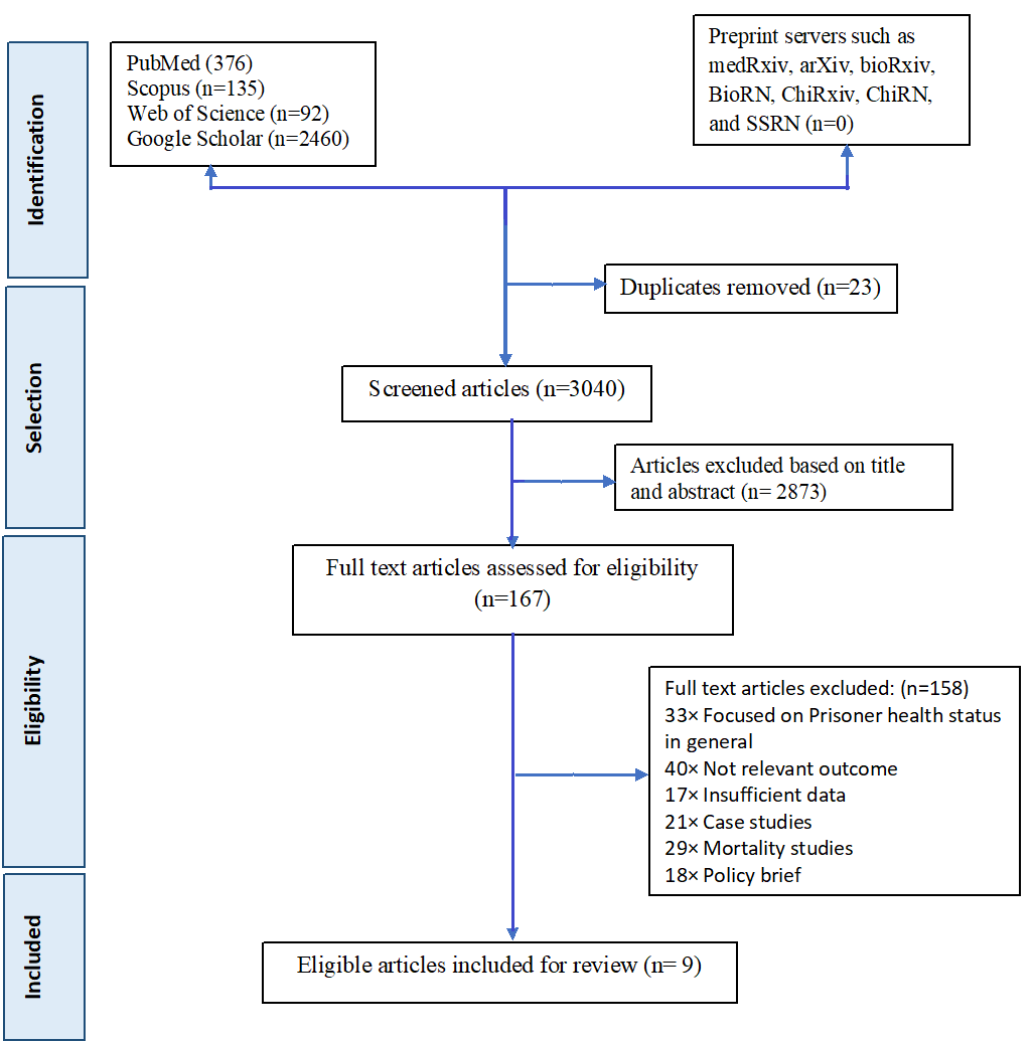
Figure 1. PRISMA flowchart for included studies in systematic review and meta-analysis of preva- lence of NCDs among prisoners of India.